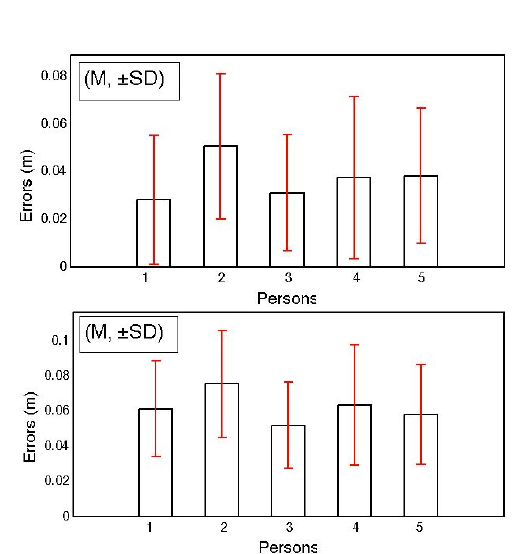
Figure 14. CoP error between the trajectories provided by Arboris replaying Kinect data and CodaMotion data on X (top) and on Y (bottom) for all the subjects. .